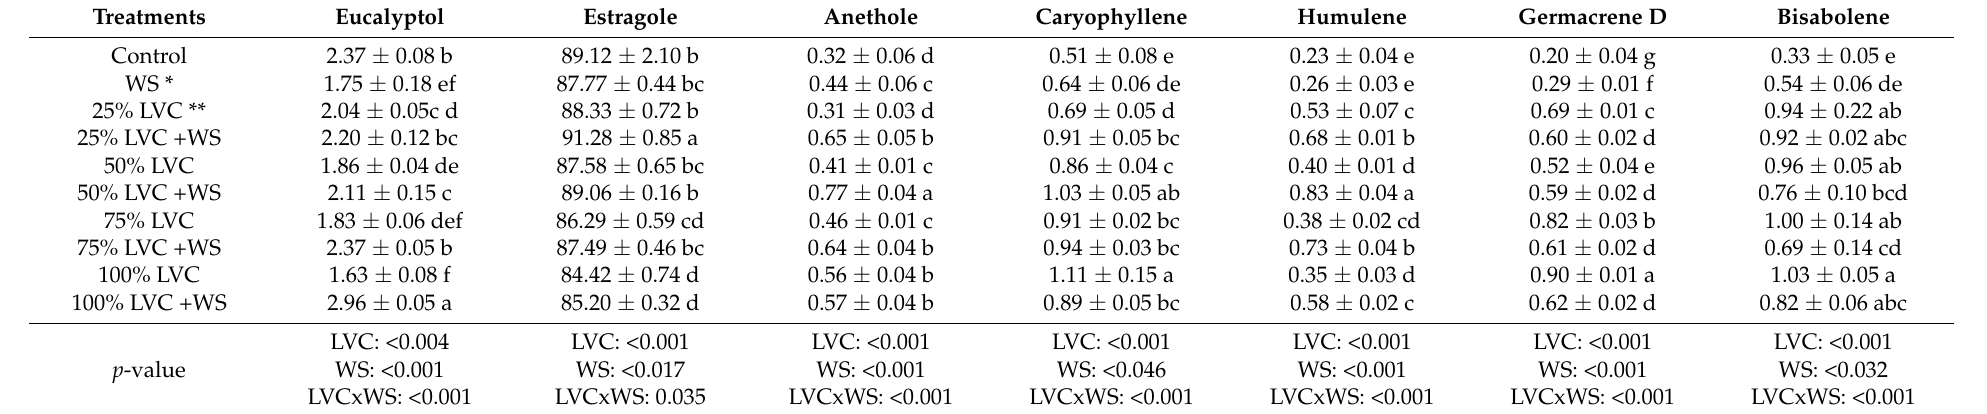
Table 3. Effects of liquid leachate obtained from vermicompost (25, 50, 75, and 100%) on essential oil compounds in basil leaves under water stress conditions (%).